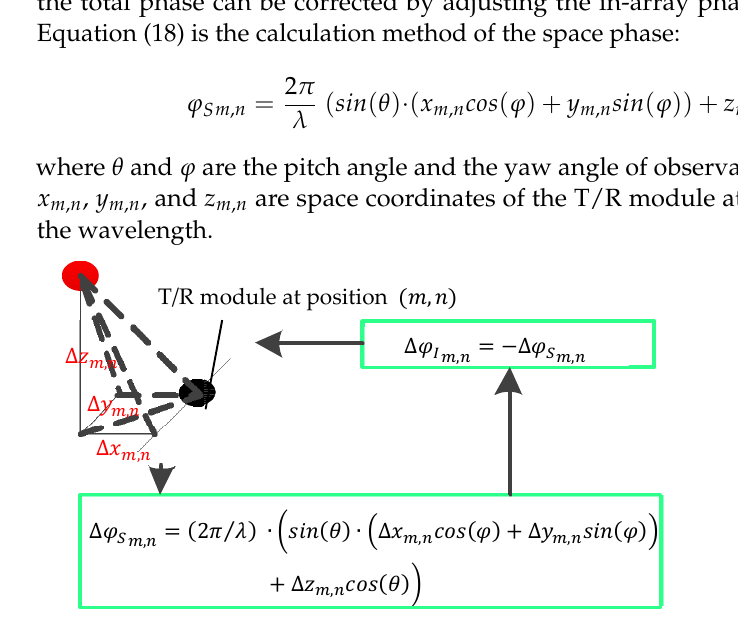
Figure 7. Principle of the thermal compensation control of the PAA. ∆ ϕ Sm , n is the change of the space phase, ∆ ϕ Im , n is the adjusted value of the in-array phase, and x m , n , ∆ y m , n , and ∆ z m , n are the thermal deformations in the X, Y, and Z axes, respectively.